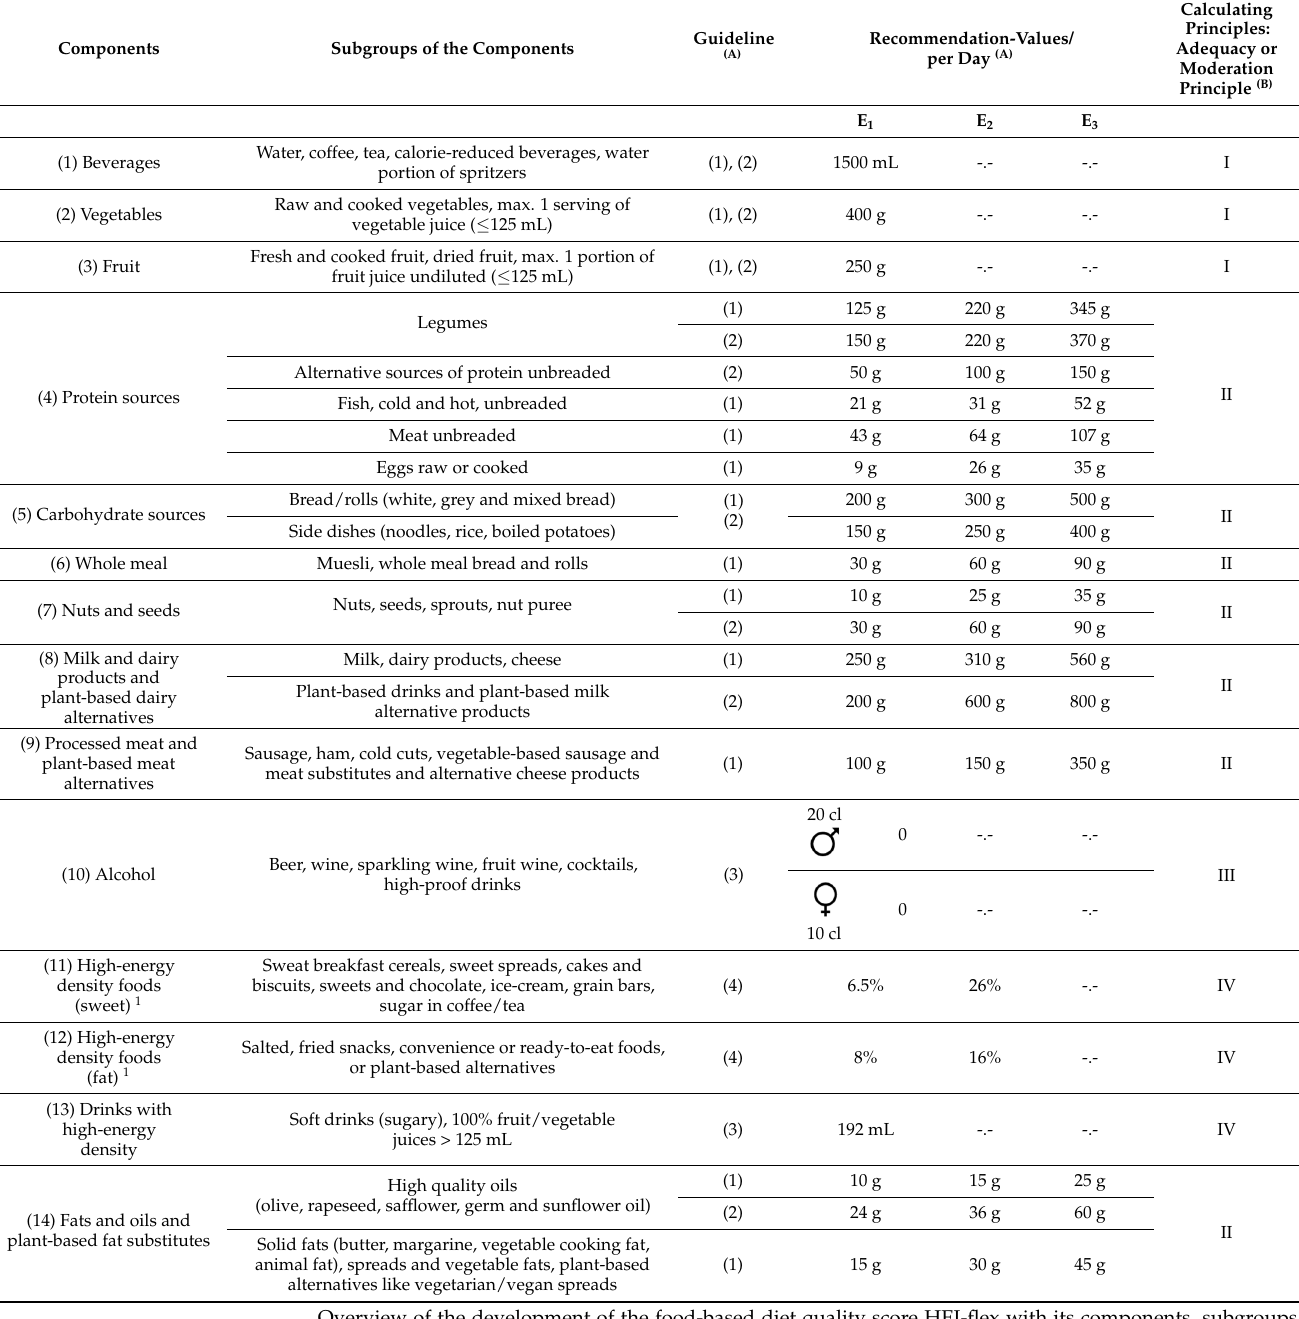
Components Subgroups of the Components Table 1. HEI-flex components, subgroups and evaluation criteria.